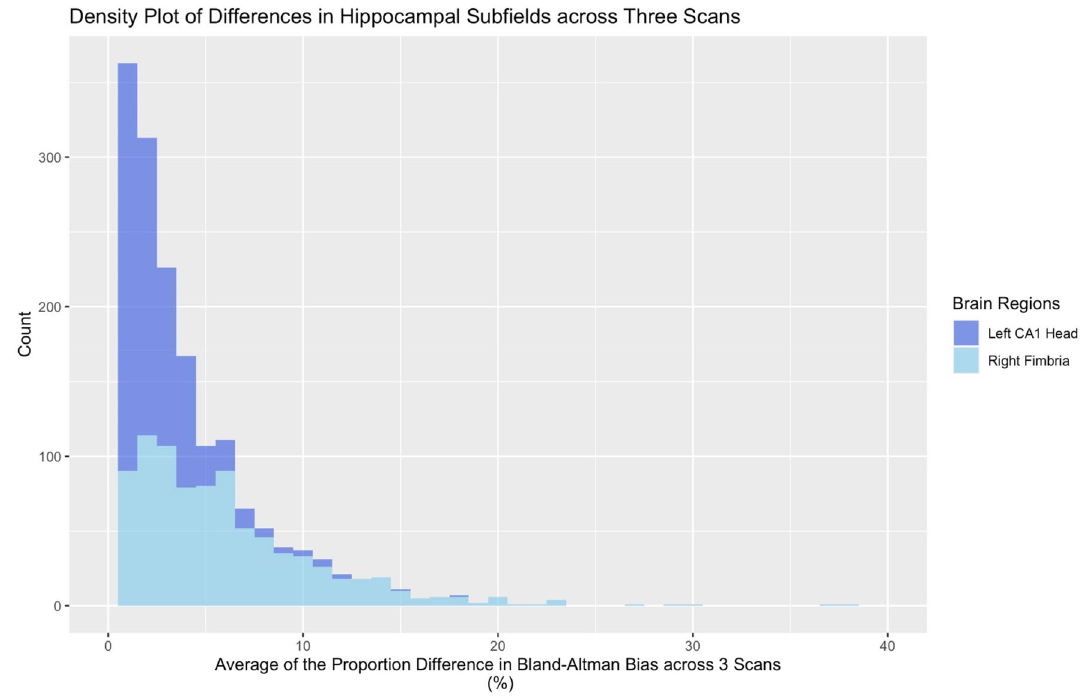
Fig. 1 Bland–Altman plots of the average difference for volume estimation across subjects’ three MRI scans for the Left Cornu Ammonis (CA) 1 Head (dark blue) and Right Fimbria (light blue). The horizontal axis indicates the average difference in Bland–Altman “ bias ” (difference between subregional volume output for different scans, as a proportion of a region’s volume), while the vertical axis indicates the number of scans with a given value. Of note, the left CA1 Head has a low degree of mean bias (as a proportion of the region’s volumes; 0.106%), while the right Fimbria has a fair degree of mean bias